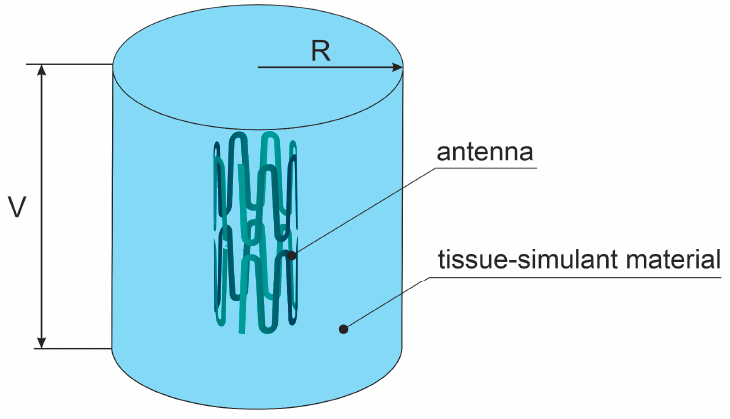
Figure 2. Antenna model in tissue simulant material.